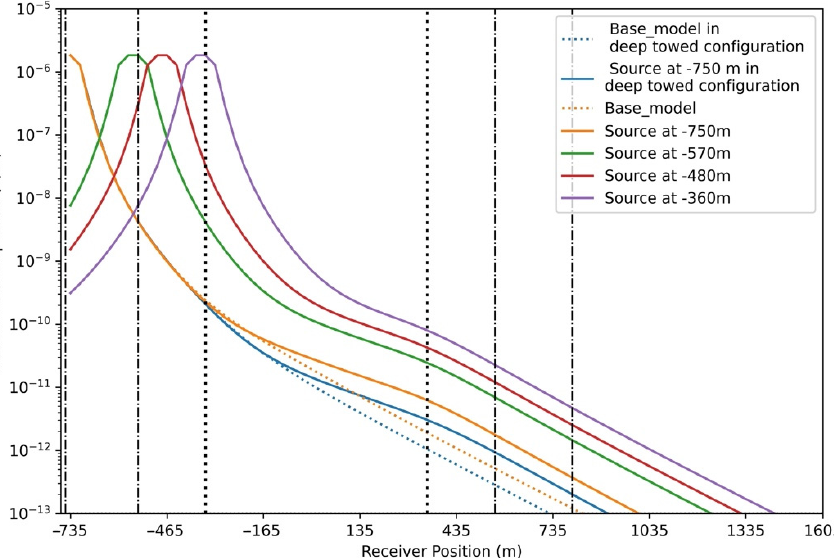
Figure 9. Electric field amplitude for stationary-receiver configurations (colored lines) and deep- towed configuration (blue line). The base model without the reservoir (dashed line) is compared with the model with the reservoir from the same source.